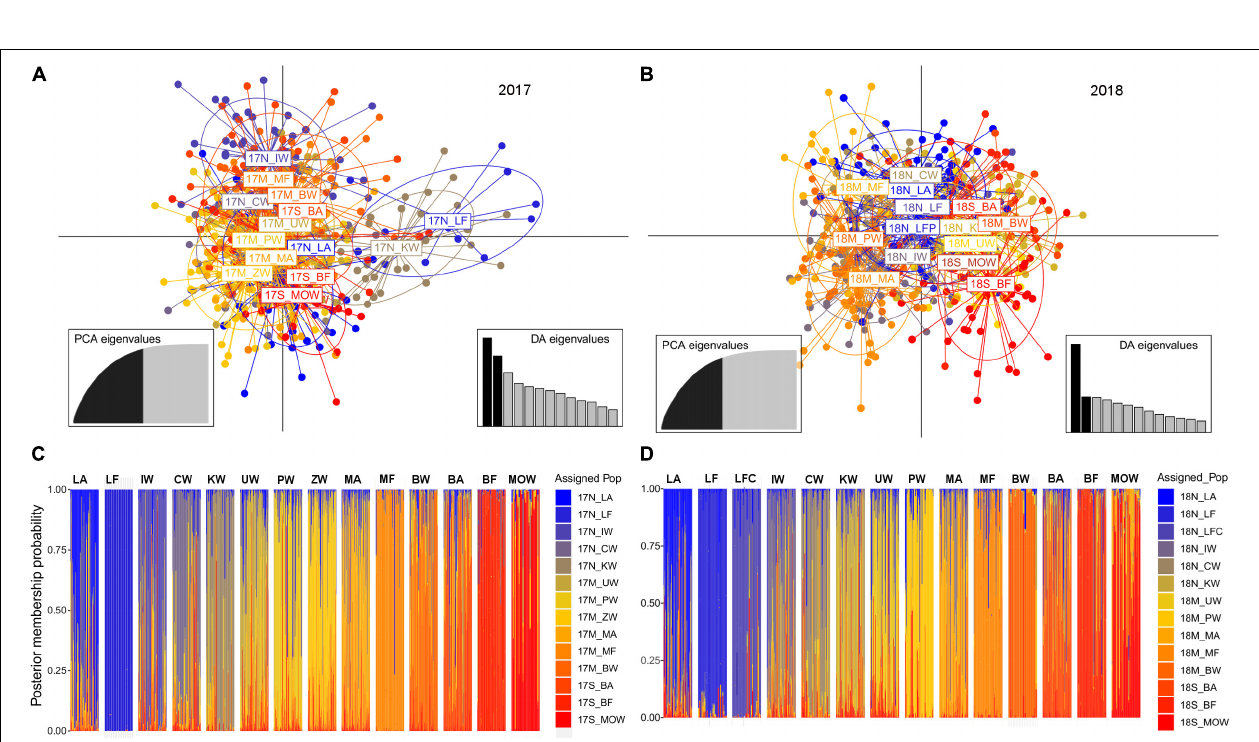
FIGURE 3 | (A,B) Scatterplot of the final Discriminant Analysis of Principal Components (DAPC) model with sampling locality as a prior, where points are individual genotypes, color-coded by their original sampling locality and surrounded by a 95% confidence ellipse. DA and PCA Eigenvalues represent the amount of genetic variation captured by the analysis for 2017 and 2018. (C,D) Membership plot showing the posterior probability assignment of individuals against their original populations.